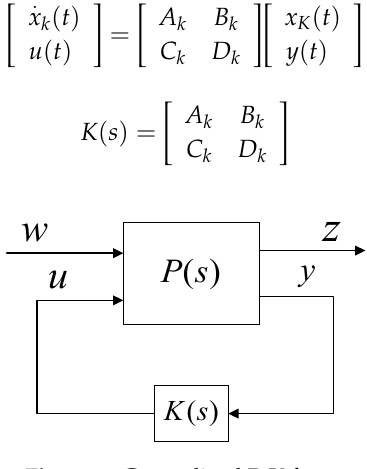
Figure 4. Generalized P-K form.